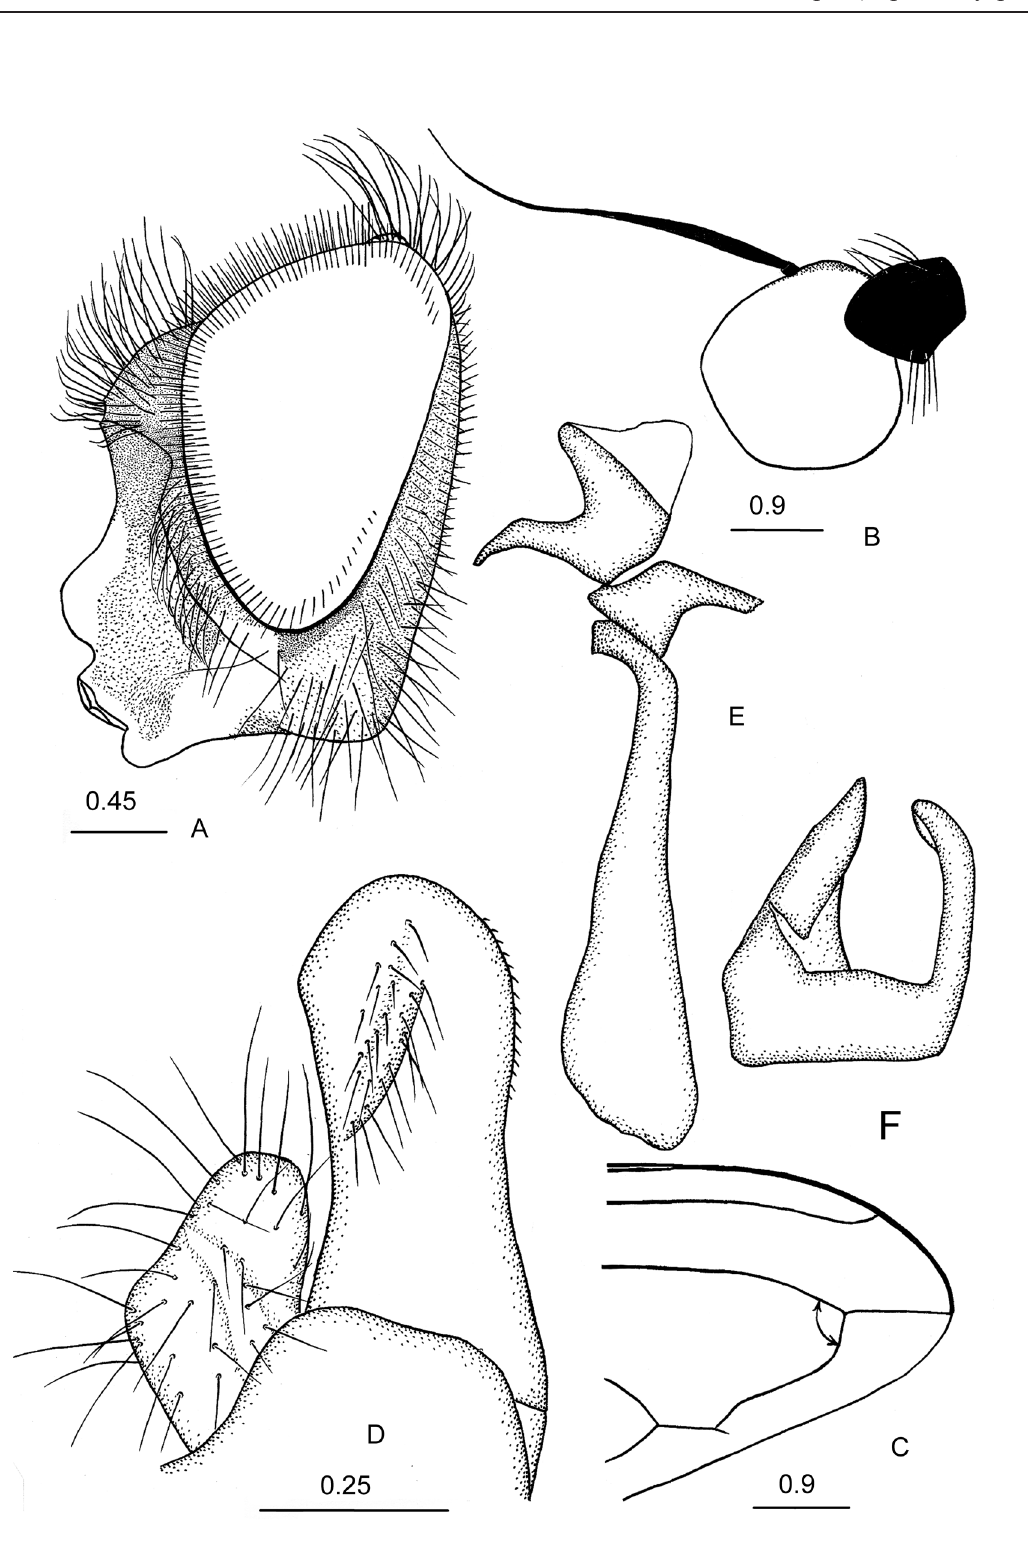
Fig. 3. Cheilosia ( Montanocheila ) albipicta sp. nov., holotype, ♂ (CSCA). A . Head, lateral view. B . Antenna, lateral view of pedicel and basoflagellomere. C . Tip of wing. D . Surstylus and gonocercus, lateral view. E . Aedeagus and aedeagal apodeme, lateral view. F . Superior lobe of hypandrium, lateral view. Scale bars indicated in